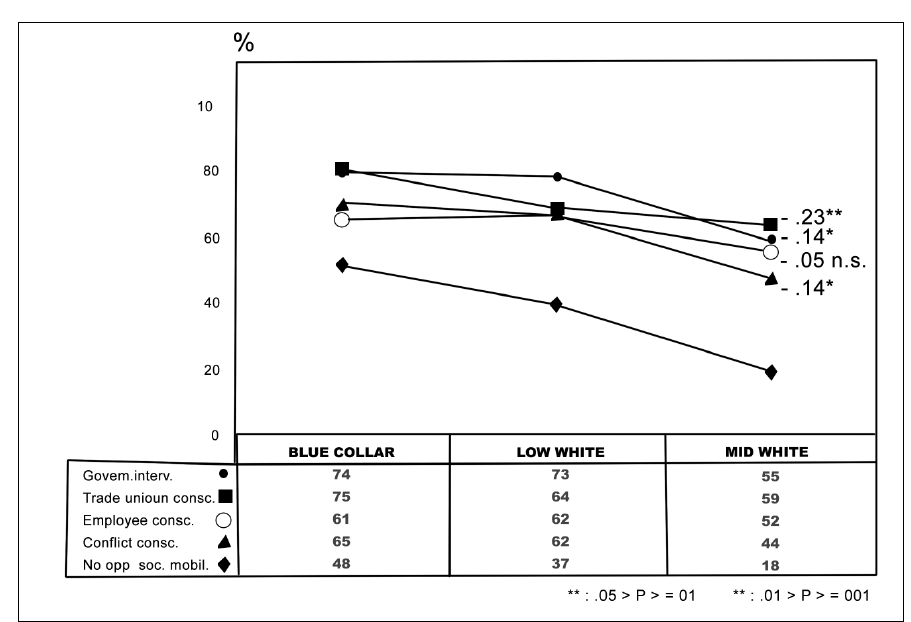
Difference between the three occupational groups on the socio- economic scales, in